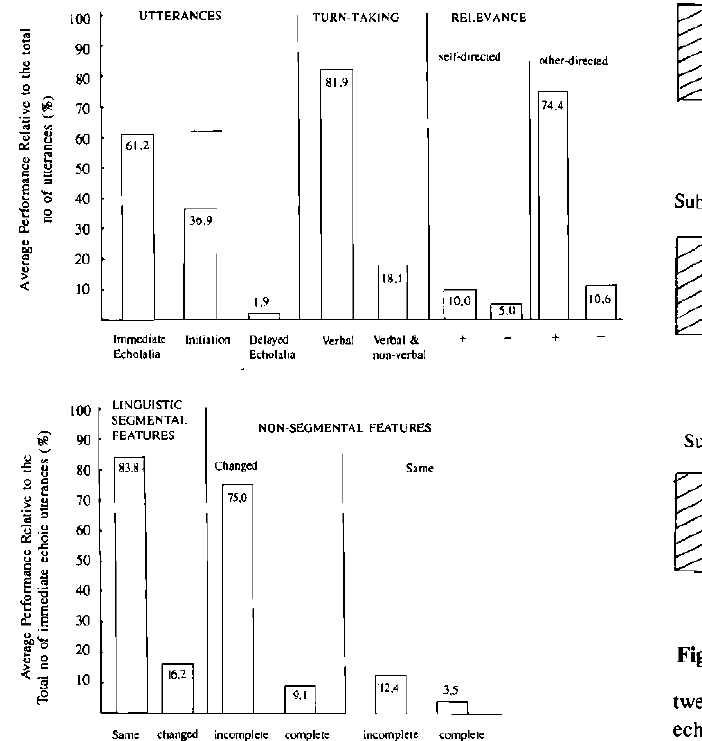
Figure 1 Categorization in percentages of the autistic subjects' echoic and non-echoic utterances.